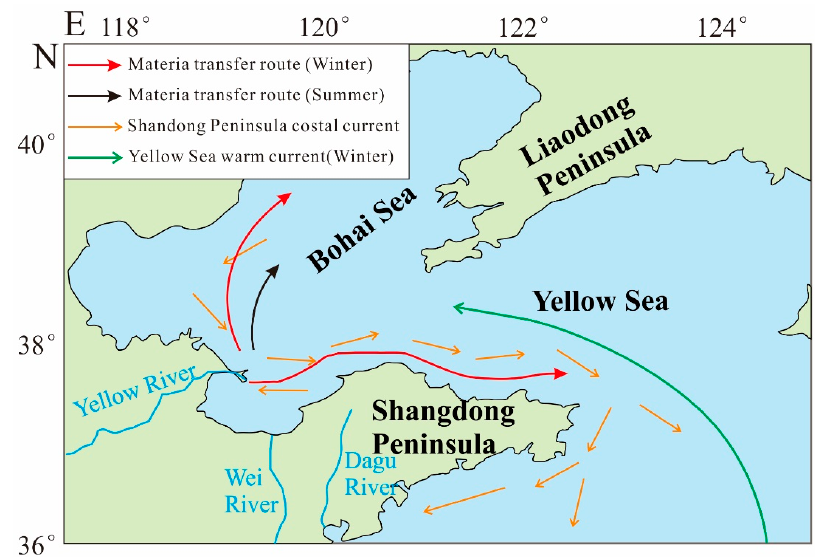
Figure 16. Shandong Peninsula offshore circulation diagram and route of seaward material transport from the Yellow River.